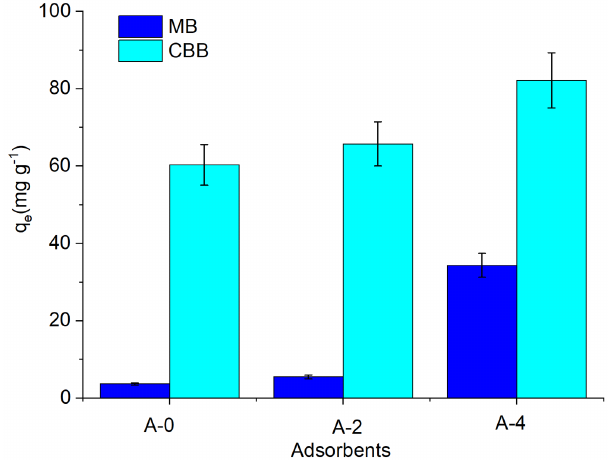
Figure 4. Adsorption of CBB and MB by A-0, A-2, and A-4 (test conditions: concentration of dye solution 50 mg L − 1 , adsorption time 12 h, adsorbent mass 2.5 mg).